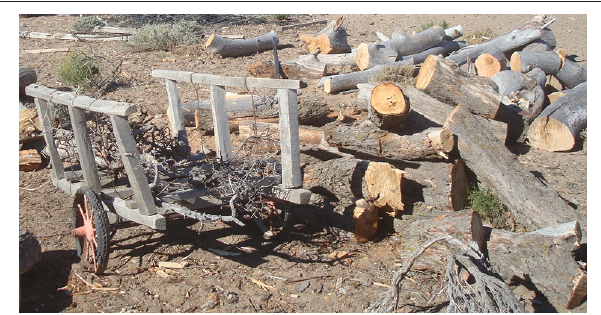
FIGURE 2 | Gathering firewood of Salix sp., P. alba and a mixture of branches from different trees with human-powered carts in Costa del Lepá,